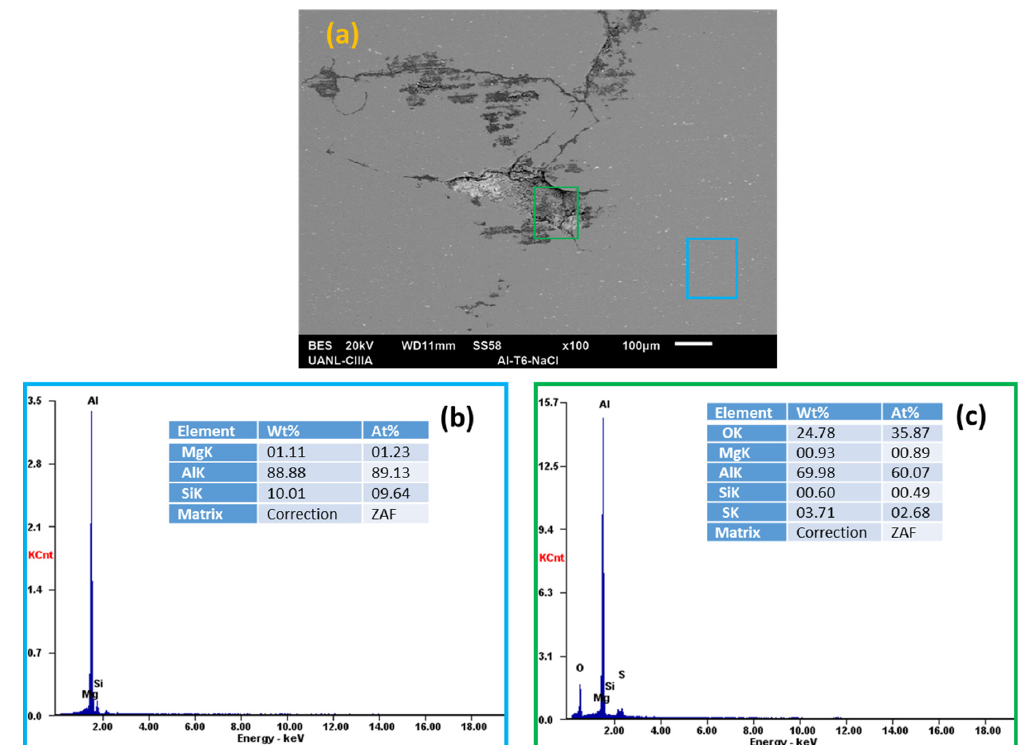
Figure 18. SEM-EDS surface micrographs of Al-6061 ( a , b ) alloys in H 2 O solution and EDS spectrum analysis: ( c ) green box, ( d ) red box, and ( e ) blue box.